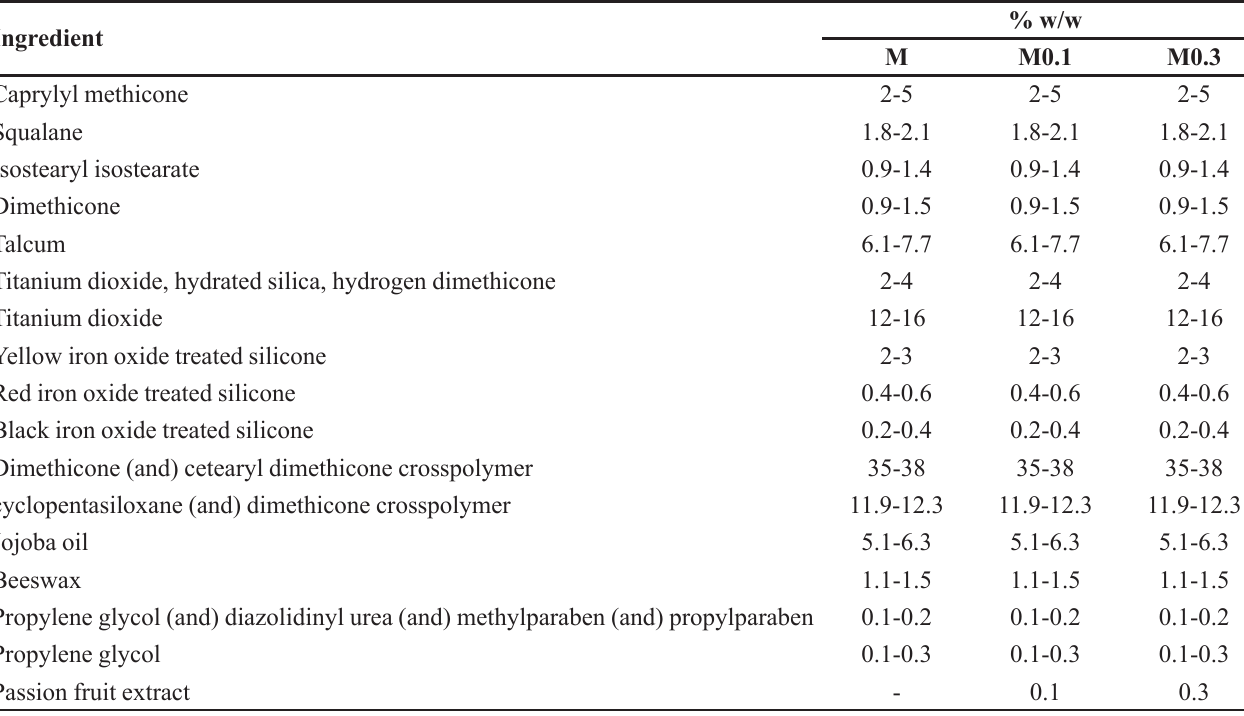
TABLE II - Composition of the concealer mousse Ingredient